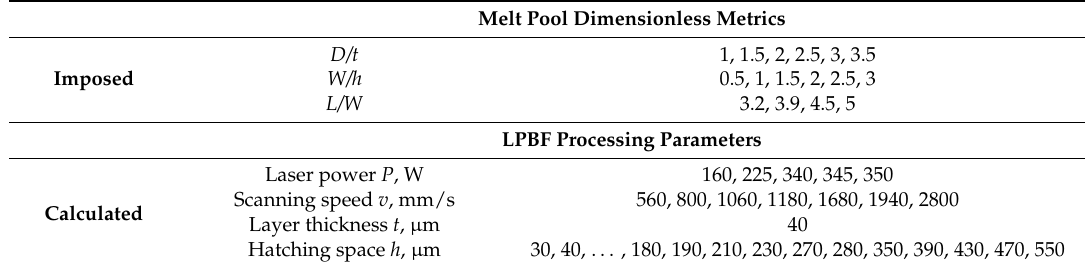
Table 2. Imposed melt pool metrics and calculated processing parameters (plan of experiments).